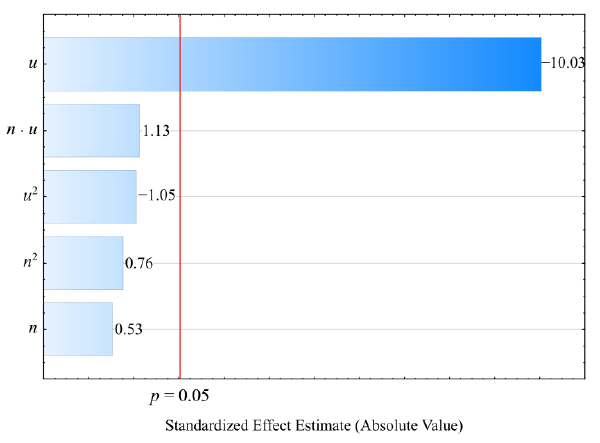
Figure 24. Pareto plots of the standardized effects of empirical full-model elongation at break ε ; the vertical line in the plot corresponds to the arbitrarily chosen level of significance ( p = 0.05).